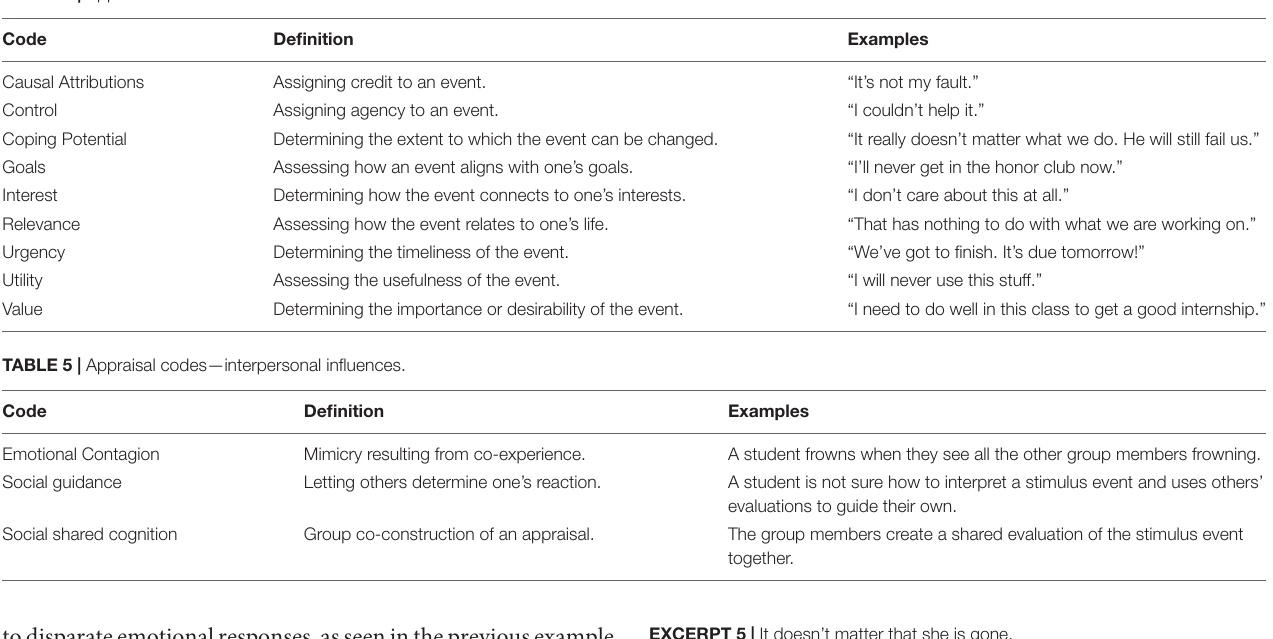
TABLE 4 | Appraisal codes—evaluations.